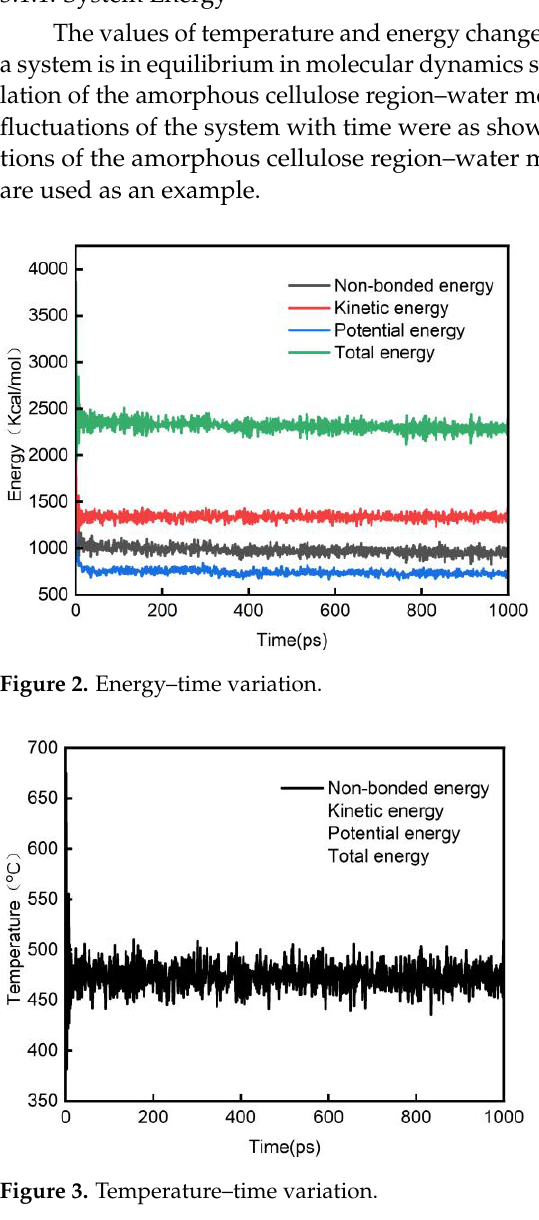
Figure 3. Temperature – time variation .